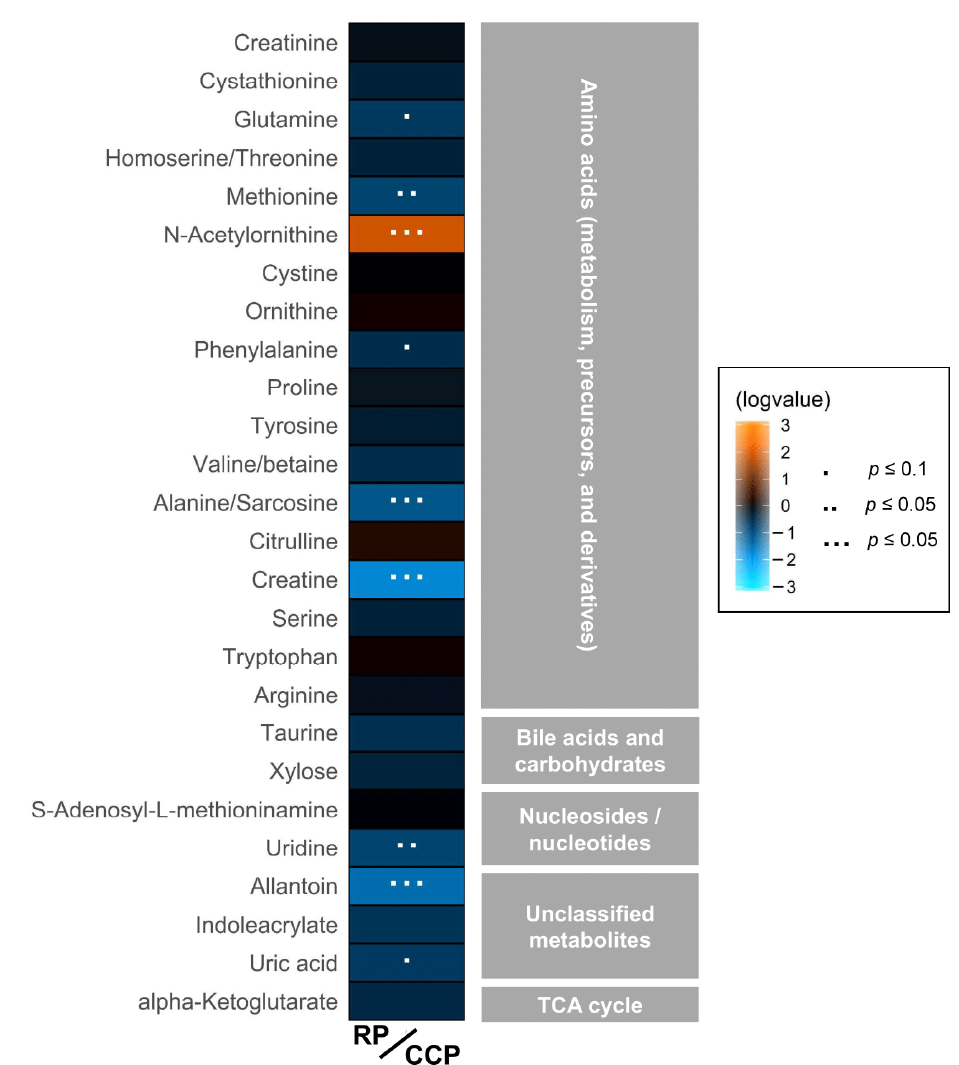
8 of 19 Figure 1. Box plots of blood plasma data conveying the differences between blood during the CCP ( n = 68) and the RP ( n = 15). Asterisks represent statistical significance ( p value ≤ 0.1 = *; p value ≤ 0.05 = **). LDH: lactate dehydrogenase ( p value 0.06), U/L; ALP: alkaline phosphatase, U/L; ALB: albumin ( p value 0.04), g/dL; BUN: blood urea nitrogen, mg/dL; GGT: gamma-glutamyl transferase, U/L; mg/dL; TRIG: triglycerides, mg/dL; AST: aspartate amino transferase ( p value 0.09), U/L; TP: total protein, g/dL; GLUC: glucose, mg/dL; Phos: phosphate, mg/dL; ALT: alanine transaminase, U/L; CREAT: creatinine ( p value 0.04). 3.3. Fold Change Analysis of Metabolites Detected in Equine Subjects during the CCP and RPs Fold changes (i.e., comparisons of metabolite abundance between sample types) were calculated for metabolites present in blood plasma. Of the metabolites detected, those clas- sified as amino acids (amino acids, precursors, derivatives, and metabolism byproducts) showed the most perturbations (Figure 2). Overall, amino acid related metabolites such